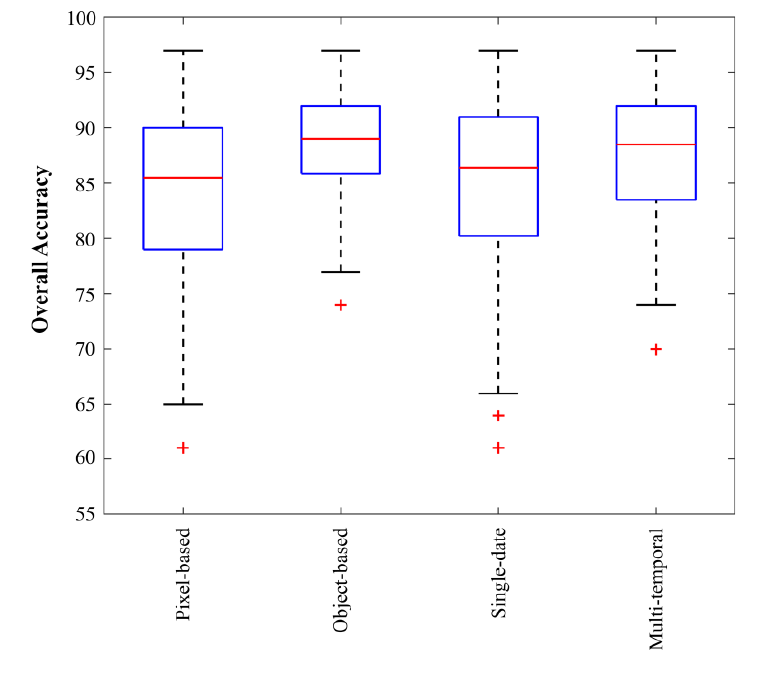
Figure 20. Overall accuracy of pixel-based vs, object-based classification and single-date vs. multi-temporal imagery. The red bar represents the median overall accuracy per classification strategy.